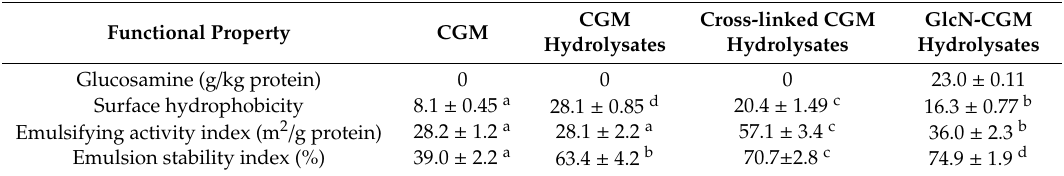
Table 1. Four evaluated indices of CGM, CGM hydrolysates, cross-linked CGM hydrolysates and GlcN-CGM hydrolysates (mean ± standard deviation, n =